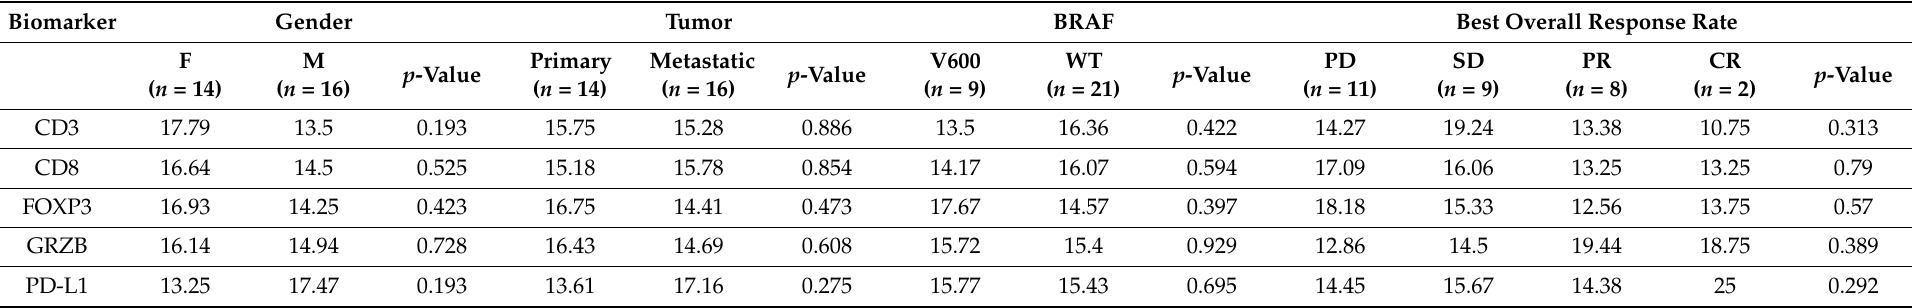
Table 3. Relationship among single TIL biomarkers with the pathological features. Representation of the intersection between the variables using the mean ranks of the analyzed groups, obtained with the Mann–Whitney test and Kruskal–Wallis rank